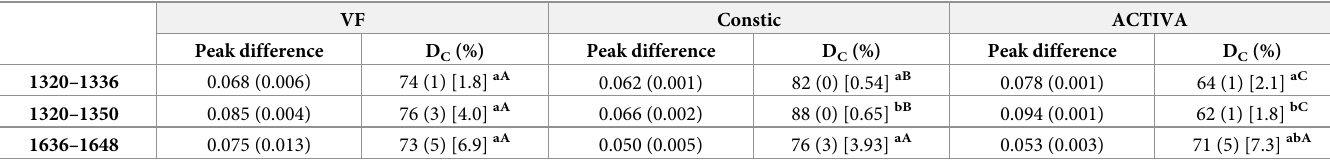
Means and standard deviations (SD) of peak heights, in absorbance units, between repetitions ( n = 3) and final D C (%) means, (SD) and [CV%] for each method, showing differences. Different lower-case letters indicate significant differences within the same column (Bonferroni, p < 0.05), while different capital letters indicate differences in the same rows (Games-Howell, p >